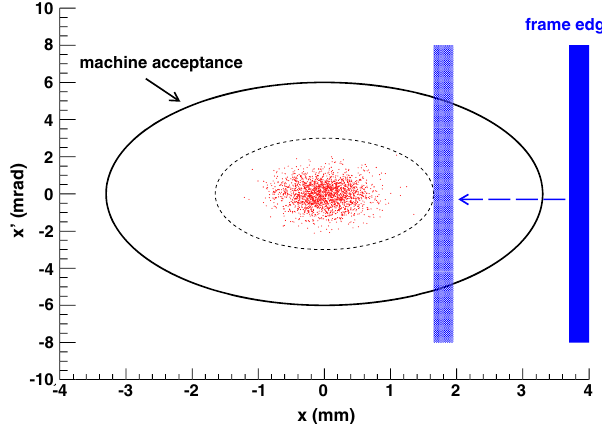
FIG. 18. Horizontal phase-space distribution at the PAX target position from a Monte Carlo simulation. A typical machine ¼ 20 μ m, A ¼ 15 μ m) is indicated by acceptance at COSY ( A x y the large ellipse. Moving a frame into the machine acceptance decreases both x and x 0 , thus reducing the beam lifetime, and allowing A and Θ to be x x